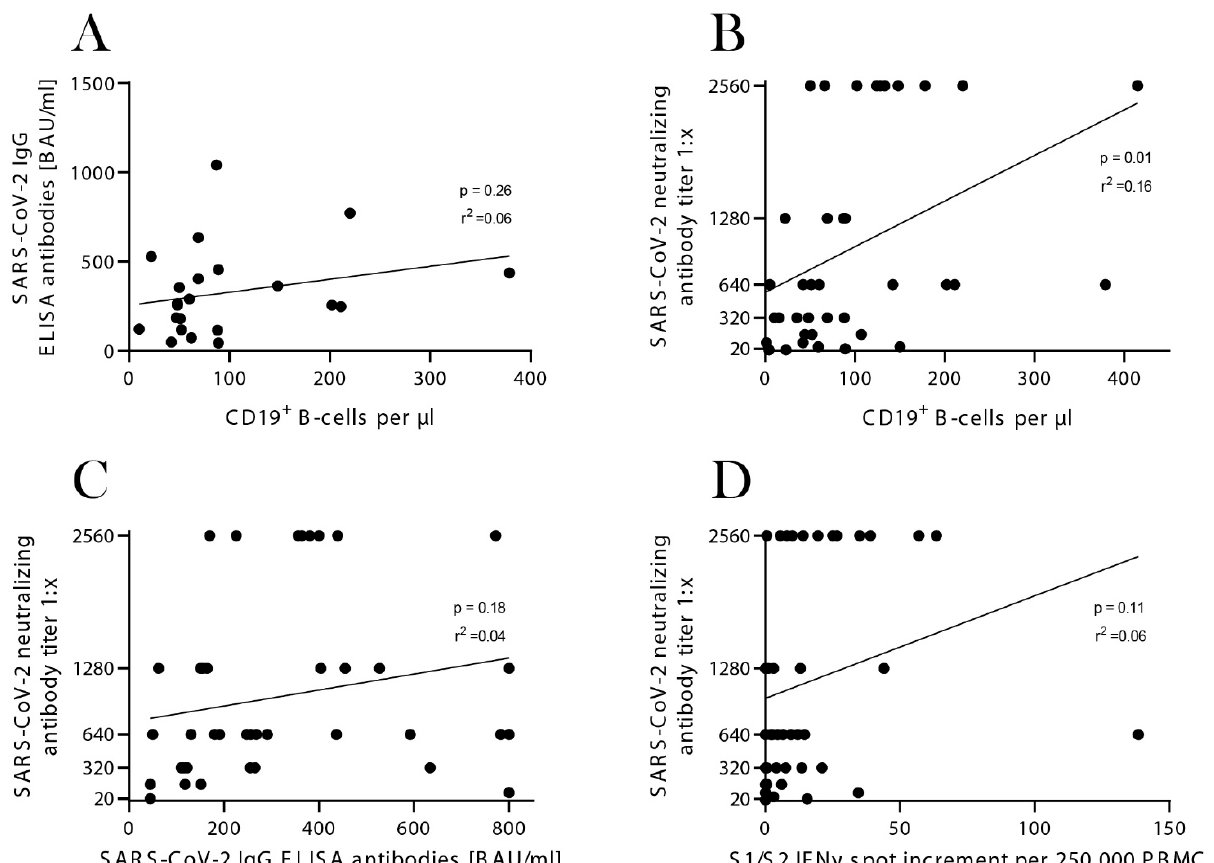
Figure 6. Correlation analyses for SARS-CoV-2 IgG ELISA antibody titers and CD19+ B-cell numbers ( A ), SARS-CoV-2 neutralizing antibody titers and CD19+ B-cell numbers ( B ), SARS-CoV-2 neutralizing antibody titers and SARS-CoV-2 IgG ELISA antibody titers ( C ) and SARS-CoV-2 neutralizing antibody titers and IFN γ ELISpot increment for the spike (S1/S2) protein ( D ). Each dot ( • ) represents one patient.